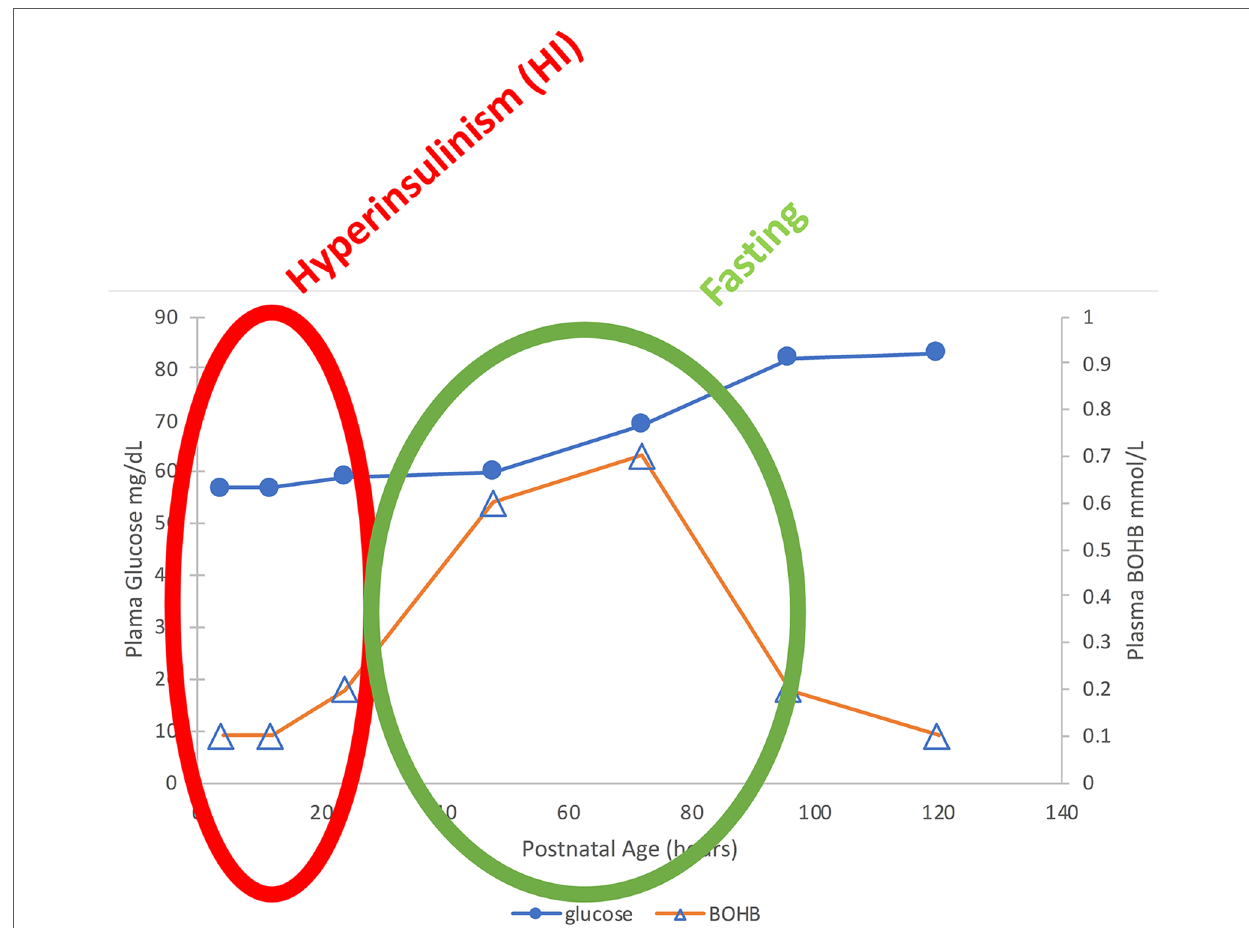
FIGURE 1 Median plasma glucose and BOHB in normal breastfed newborns. Note the two phases of “ neonatal hypoglycemia ” : (1) Birth — 24 h: Hypoglycemia with hypo-ketonemia due to transient Hyperinsulinism; (2) 36 – 72 h in breastfed babies: Milder hypoglycemia with hyper-ketonemia= “ Fasting ”